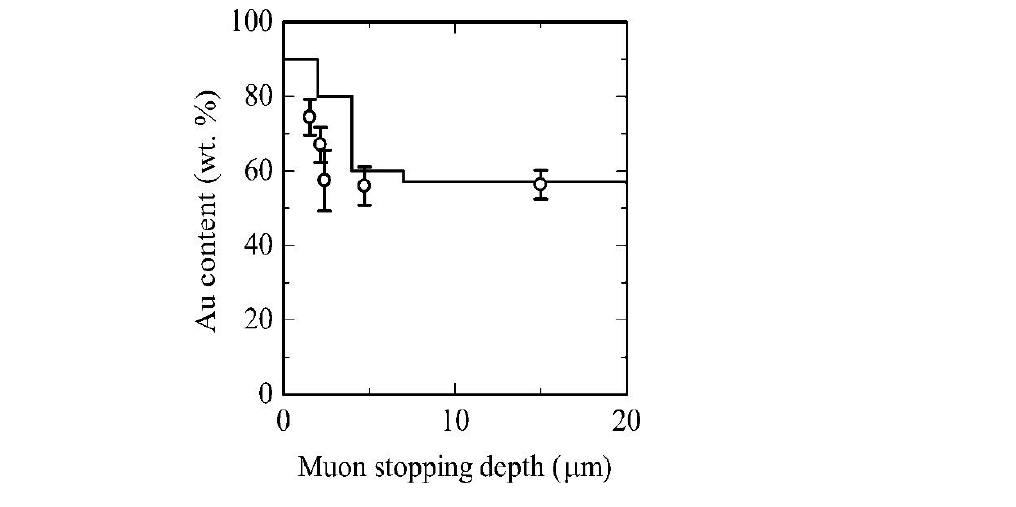
Figure 8. Gold variation within the sample thickness. Reprinted with permission from “Nondestructive Elemental Depth-Profiling Analysis by Muonic X-ray Measurement”. K. Ninomiya, M. K. Kubo, T. Nagatomo, W. Higemoto, T. U. Ito, N. Kawamura, P. Strasser, K. Shimomura, Y. Miyake, T. Suzuki,